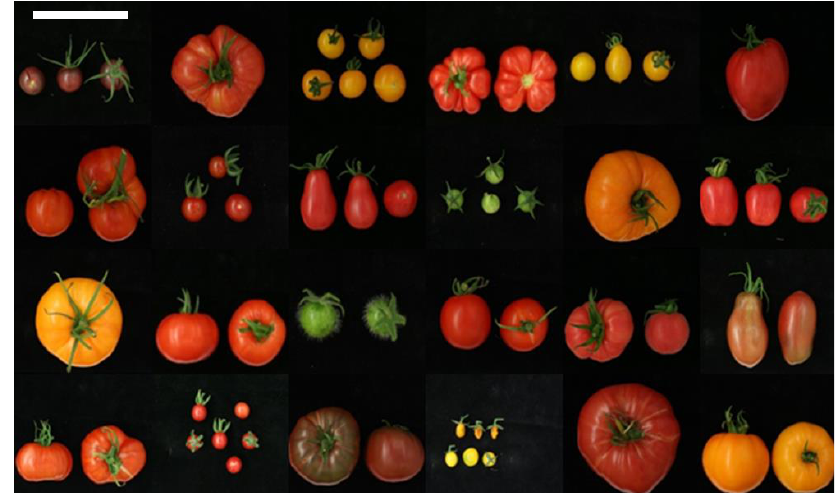
Figure 1. Morphological variation of fruits from the core collection accessions. The picture shows a compilation of fruits from core collection accessions with different colours, shapes, and sizes to illustrate the phenotypic variation present in the core collection. Scale bar is 10